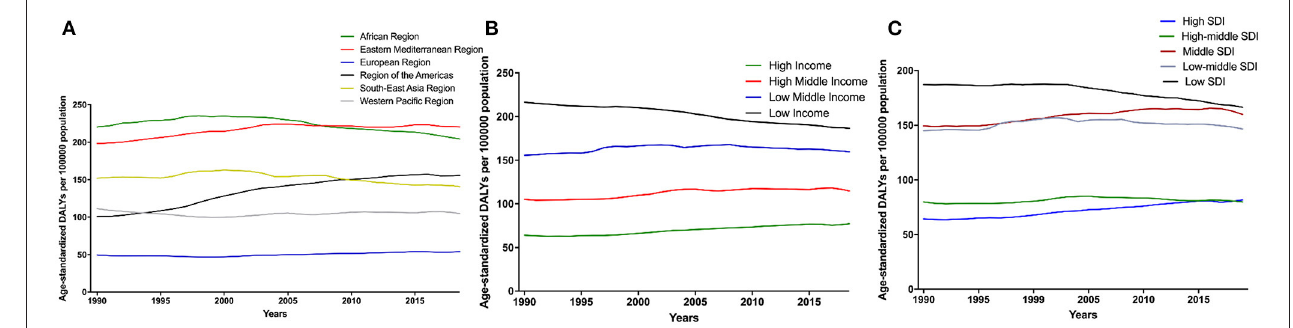
FIGURE 4 | Time trends of global disease burden of CKD due to hypertension in 1990–2019 among different regions (A) , Global disease burden of CKD due to hypertension by different levels of income regions (B) , and age-standardized DALY rate by different levels of SDI regions (C) . CKD, chronic kidney disease; DALY, disability-adjusted life-year. SDI, socio-demographic index.